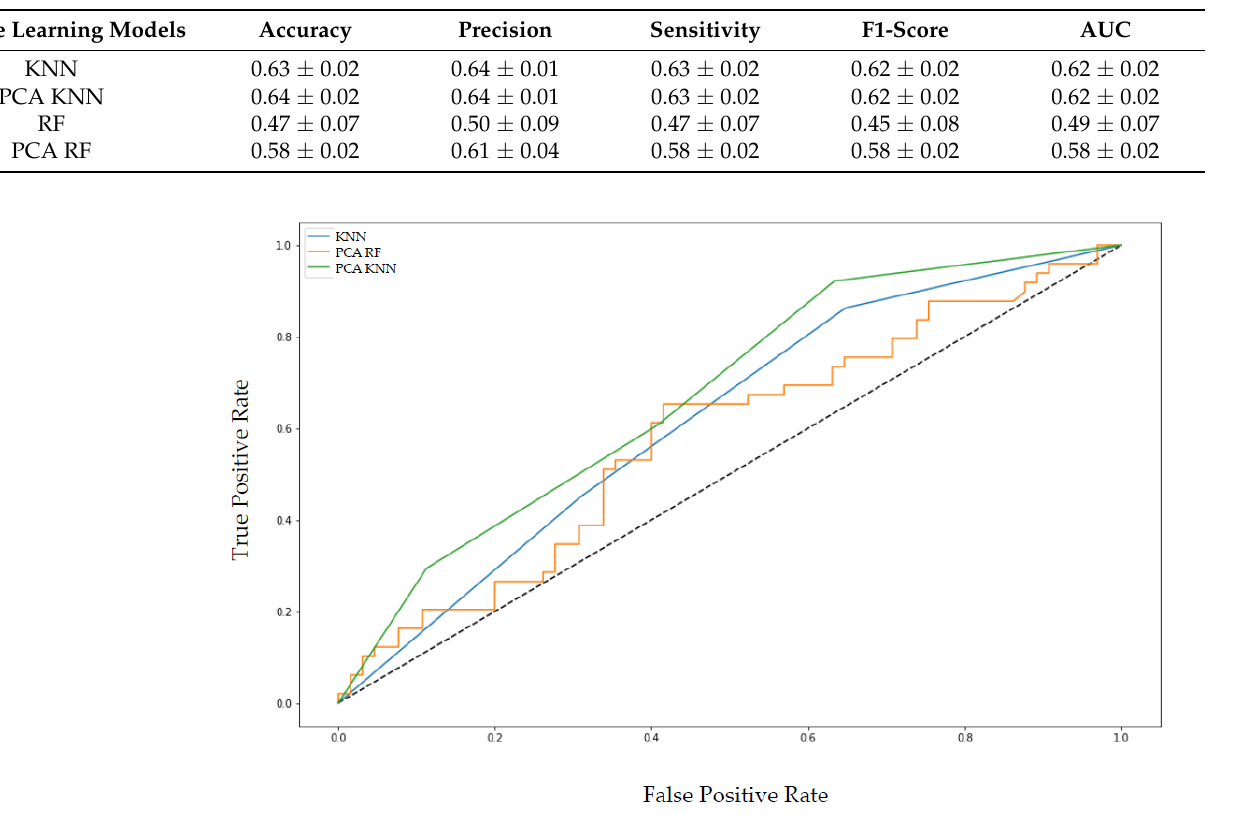
Figure 5. The receiver operating characteristics (ROC) curves of the KNN and PCA KNN algorithm yielded an area under the curve (AUC) of 0.62. In contrast, PCA RF yielded an AUC of 0.58 for classification performance of complete remission versus relapse of MCL.